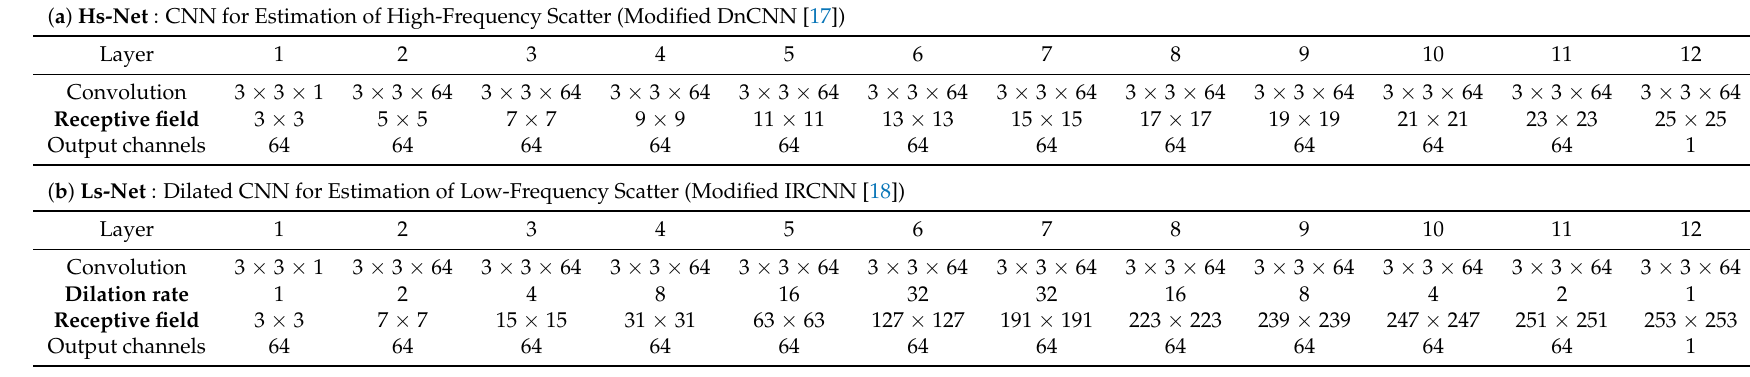
Table 2. Network specifications of Hs-Net and